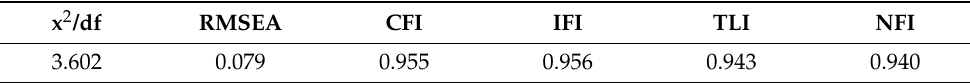
Table 4. Test of the degree of fit of the sense of social responsibility consciousness